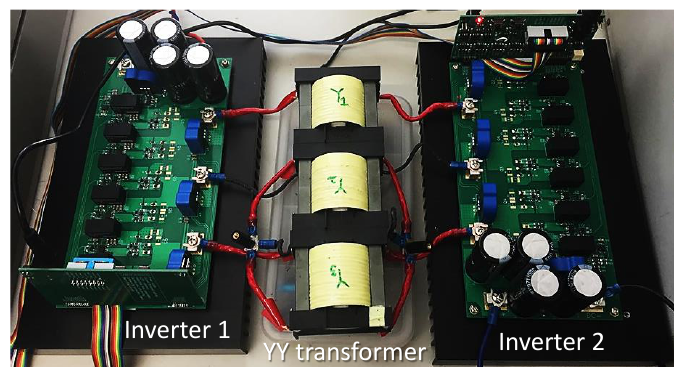
Figure 9. A 10 kW, three-phase DAB converter prototype.